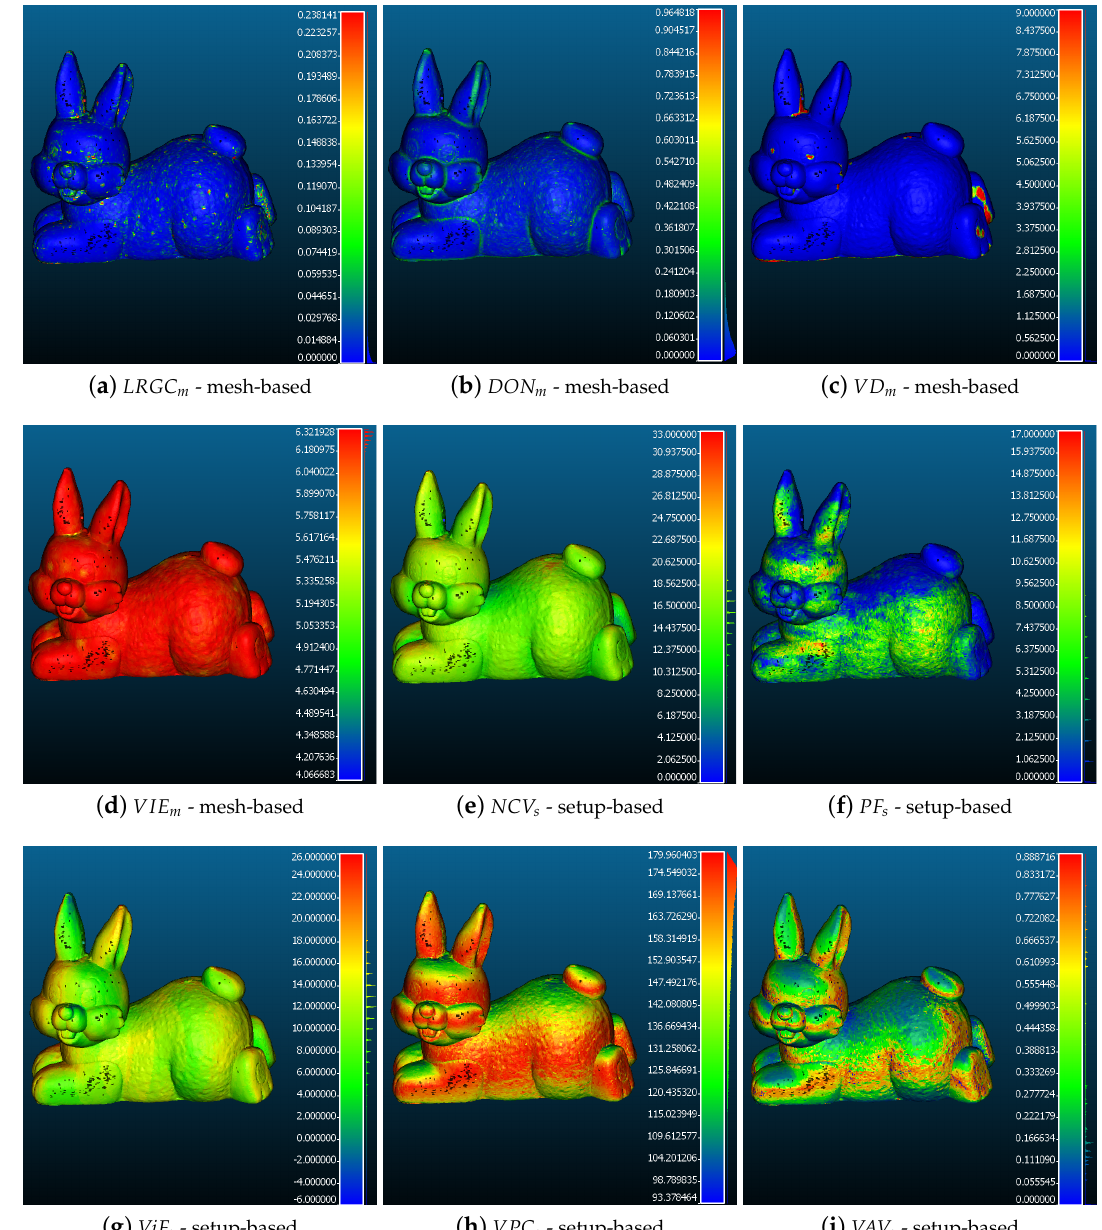
Figure 4. Visualization of all the proposed metrics as heat maps. For Local Roughness from Gaussian Curvature (LRGC), DON m , VD m , higher values (indicated with red color) indicate higher risk of noise, while for VIE m , NCV s , PF s , ViF s , VPC s and VAV s —higher values, indicate lower risk of